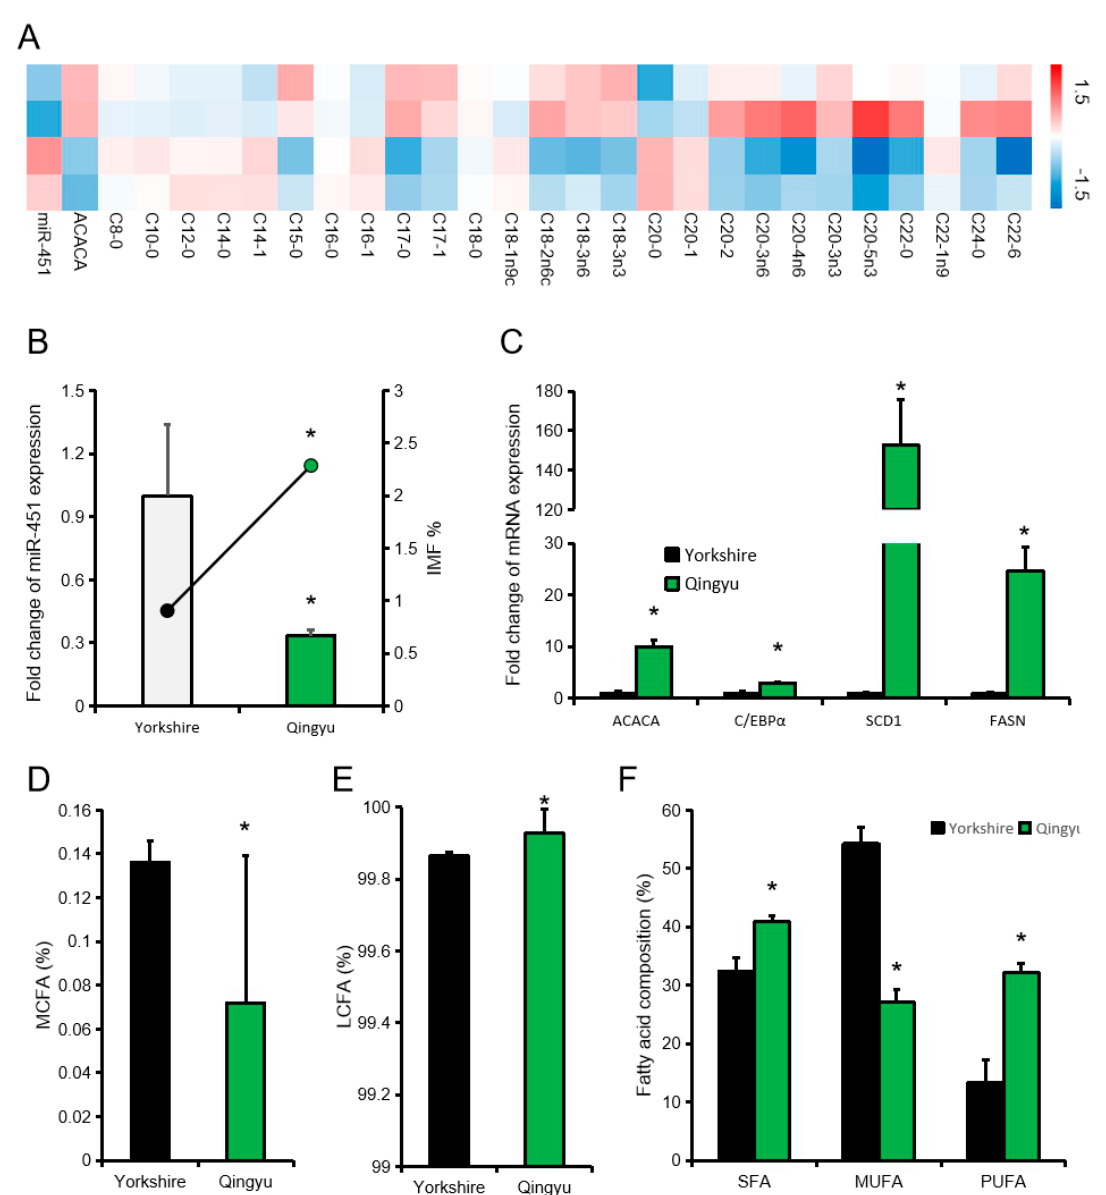
Figure 5. Effect of ssc-miR-451 on fatty acid composition of longissimus dorsi. ( A ) Composition of 26 fatty acids of longissimus dorsi muscle. ( B ) Intramuscular fat content and miR-451 expression levels in Qingyu pigs and Yorkshire pigs, n = 3. ( C ) Expression of candidate genes for fat deposition in two pig breeds, n = 3. ( D ) Composition of medium chain fatty acids (MCFA) of longissimus dorsi muscle in Qingyu Pigs and Yorkshire Pigs. n = 6. ( E ) Composition of long chain fatty acids (LCFA) of longissimus dorsi muscle in Qingyu Pigs and Yorkshire Pigs n = 6. ( F ) Fatty acid composition of longissimus dorsi muscle in Qingyu Pigs and Yorkshire Pigs. n = 6. * p < 0.05. The data is from our previous article [13].